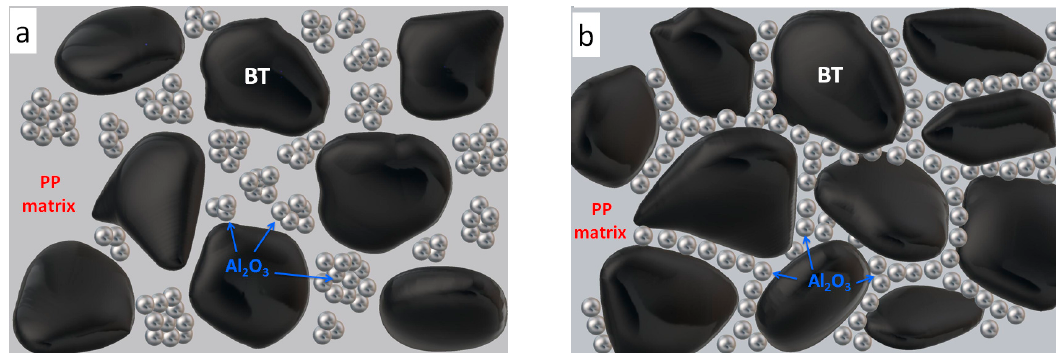
Figure 4. The schematic diagram of synergistic mechanism of thermal conductivity in f PP = 50% Al 2 O 3 /BT/PP composites: ( a ) f BT : f Al